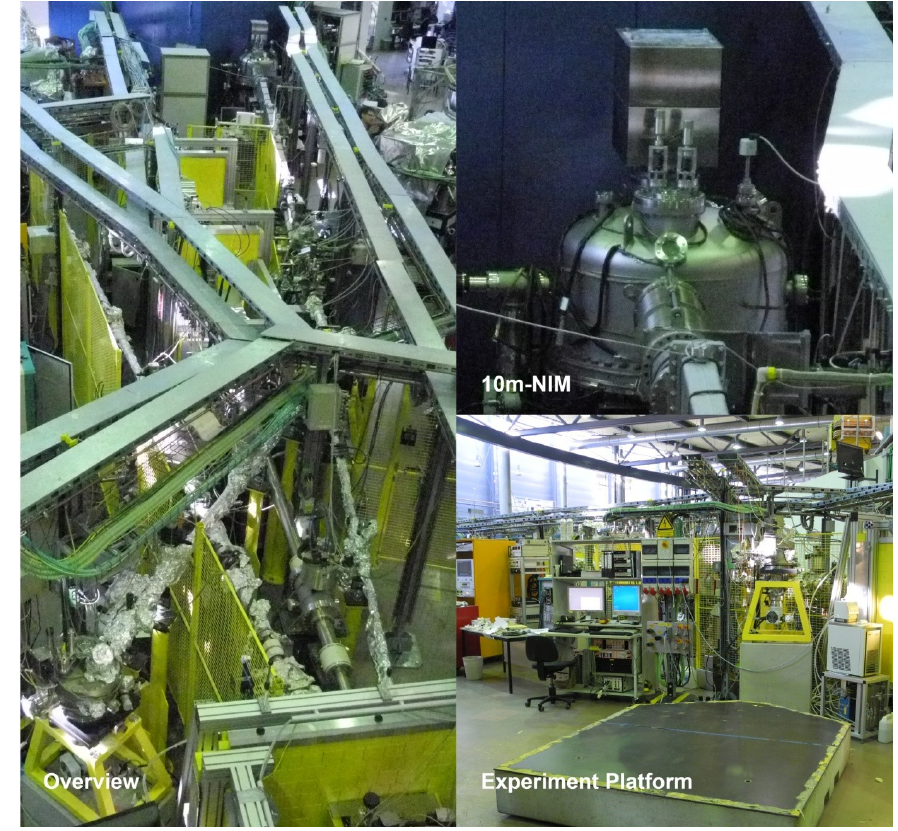
Figure 1: Views of beamline U125-2 NIM.